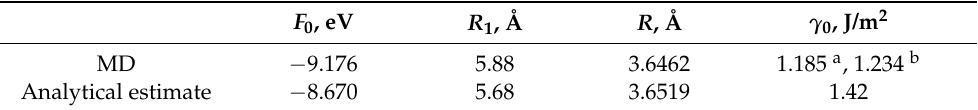
Table 1. Comparison of the results of analytical estimates of some characteristics of the Al/C 60 interface with the data of MD simulation.